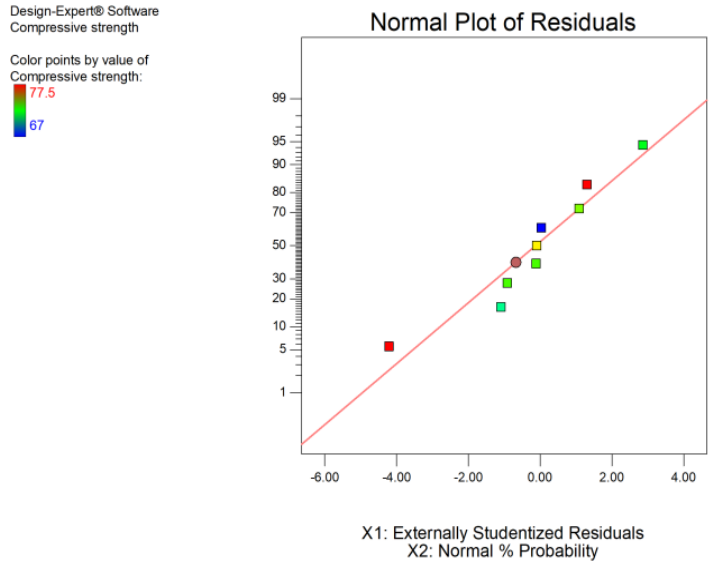
Figure 13. The normal plot of residual compressive strength of EGC .